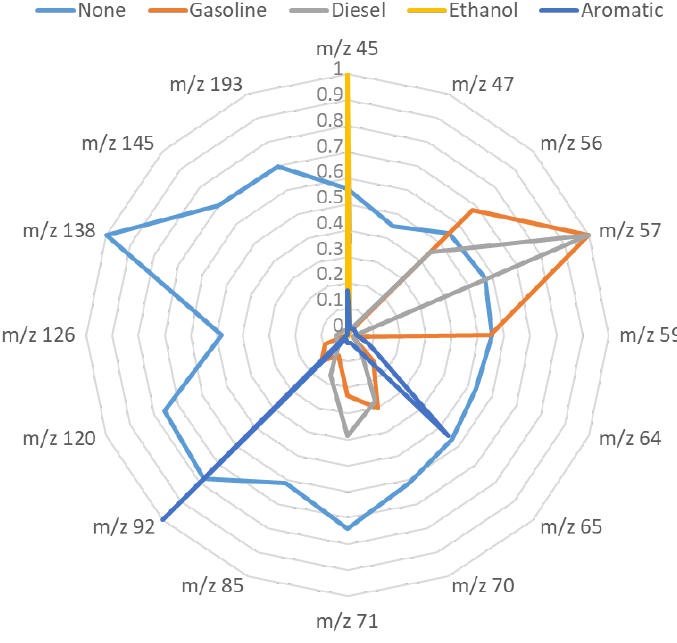
Figure 5. PDP fingerprints obtained by displaying the values of the m / z selected in the linear discriminant analysis (LDA).